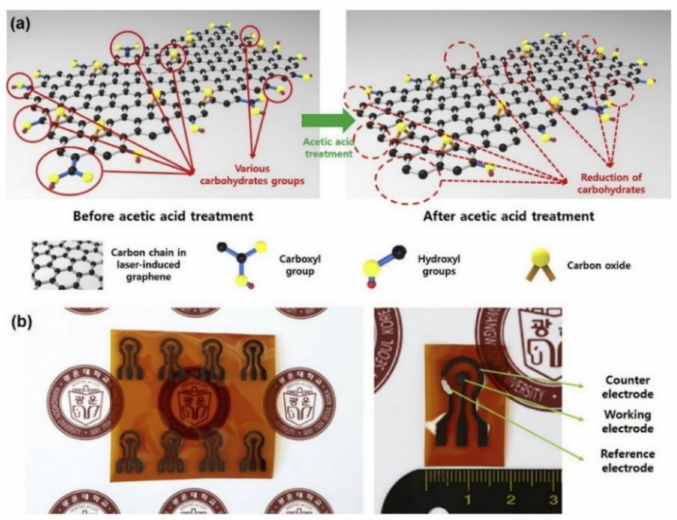
Figure 6. ( a ) Surface-modification of the sensors. ( b ) Chemical vapor (CV) technique was used to test the prototypes for glucose measurement [145]. Copyright 2020